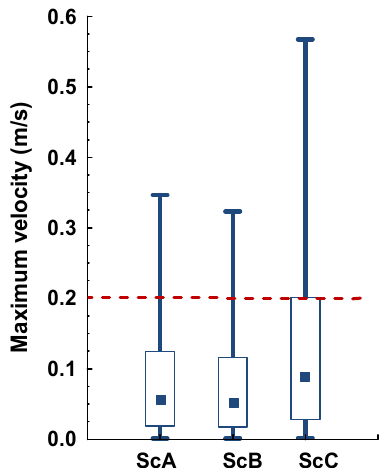
increased from about 0.1 m/s in ScB, to 0.2 m/s in ScC (Figure 7). Distributions of maxi- mum daily velocity versus pipe diameter for the scenarios of average day, average winter day, and maximum day were also investigated (Figure S7). For both groups of pipes (D ≤ 100 mm and 100 < D ≤ 200 mm), the 75th percentile maximum velocity never reached 0.2 m/s, even in the maximum day scenario.